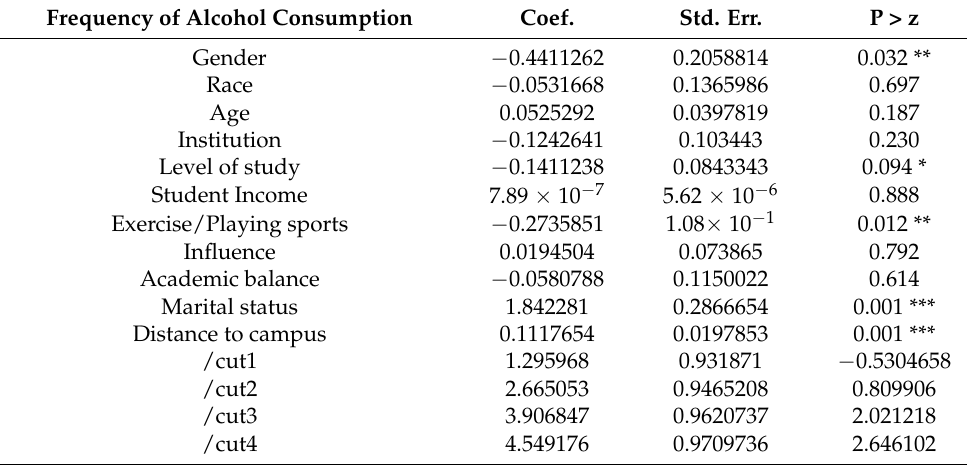
Table 6. Factors influencing university students’ alcohol